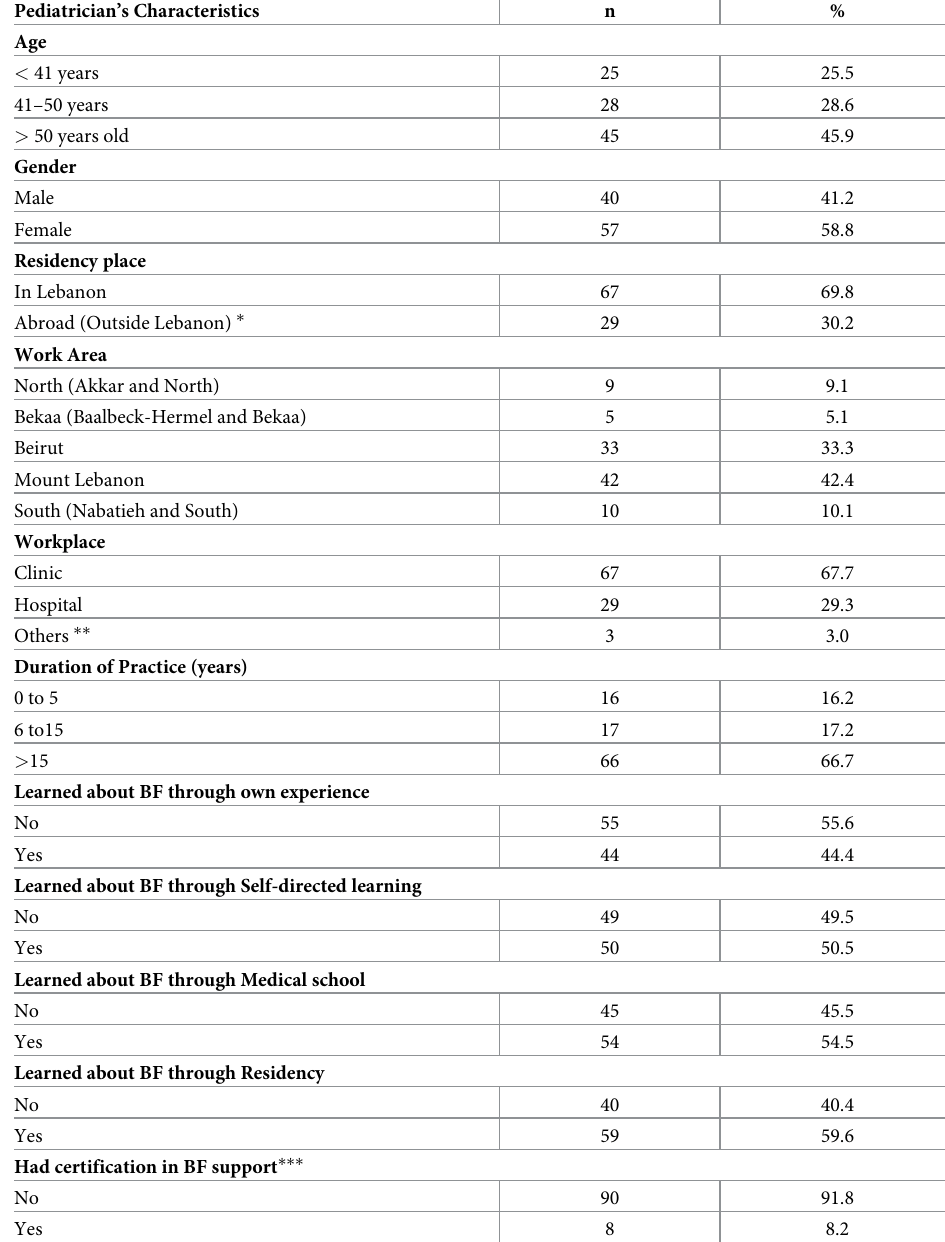
Table 1. Characteristics of study